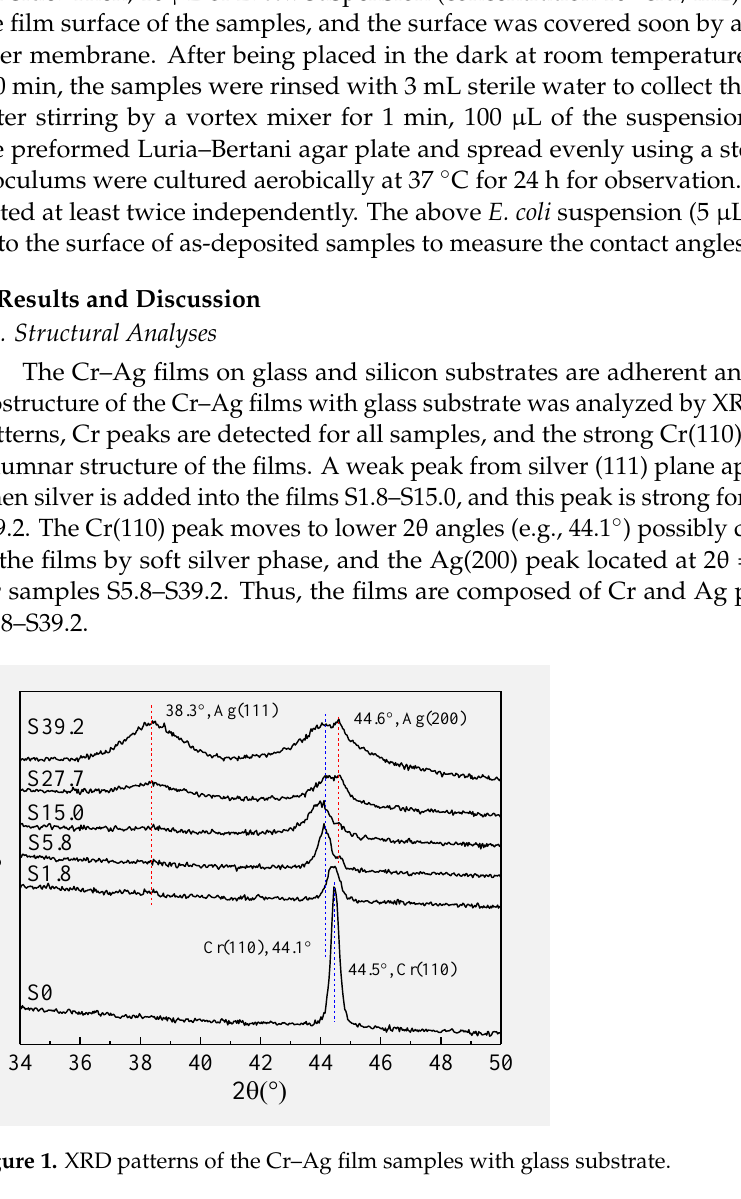
appear at the surface of sample S27.7, and their density is much lower than those on DLC – not occur for the Cr–Ag